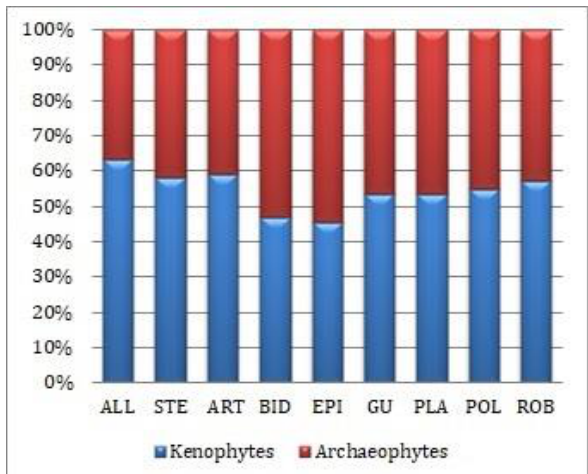
Fig. 4. Distribution of alien species in ruderal vegetation by arrival time